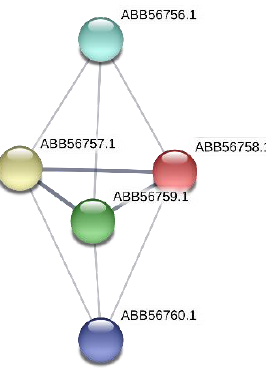
Figure 6. Network of ABB56758.1 protein ( Synpcc7942_0726 ) and its protein partners according to STRING (https://string-db.org) is presented. In this figure: the protein ABB56756.1 (Synpcc7942 _0724) and the protein ABB56760.1 ( Synpcc7942_0728 ) are conserved hypothetical proteins; the protein ABB56757.1 ( Synpcc7942_0725 ) is DEAD/DEAH box helicase-like enzyme; the protein ABB56759.1 ( Synpcc7942_0727 ) is putative DNA primase/helicase. Table 3. The genes and corresponding proteins, which were impaired in 2-nonanone-resistant mutants of Synechococcus.